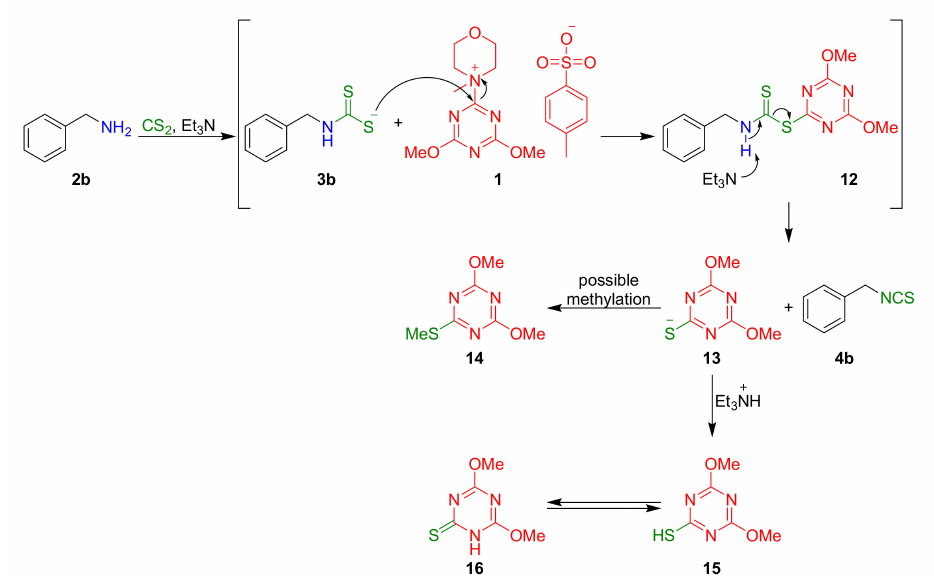
Figure 9. Possible mechanism for synthesis of